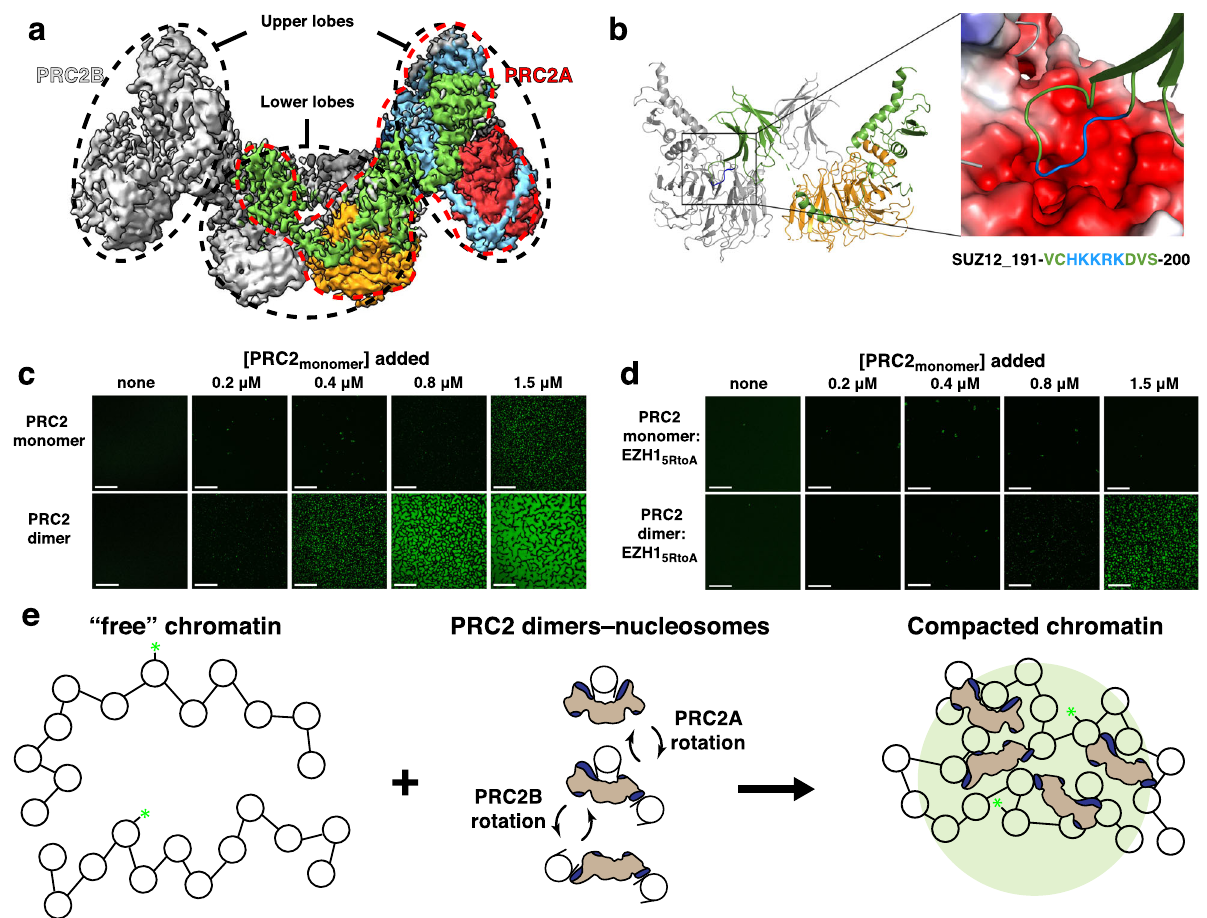
Fig. 3 PRC2 dimers promote chromatin compaction. a Cryo-EM map showing the PRC2:EZH1 dimer. Subunits are colored as in Fig. 1. One PRC2 monomer is highlighted in color and by a red dashed line. b , left panel: Isolated view of the dimeric interface of PRC2:EZH1 showing that the C2 domain of SUZ12 (green) from one PRC2:EZH1 interacts with RBAP48 from the other PRC2:EZH1 (gray). Right panel: Zoomed-in view of the basic loop (blue) in the C2 domain interacting with the acidic surface of RBAP48. Electrostatics were calculated using APBS in PyMol. The sequence of the basic residues in the C2 domain is shown and colored blue. c Confocal micrographs of serial twofold dilutions of PRC2:EZH1 mixed with nucleosome arrays showing compaction of chromatin into droplets. Scale bar: 100 μ m. The fi nal concentration of PRC2 in the reactions is indicated. Molarity is based on the expected size of PRC2: EZH1 monomers. All samples contain 3 μ M total nucleosomes, assembled into arrays with 12 nuclesomes spaced 40 bp apart. Experiments were repeated at least three times with independently puri fi ed complexes and were consistent with each other. d Chromatin compaction as promoted by PRC2:EZH1 5RtoA mutant complexes. Concentrations and scale are as in c . Experiments were repeated twice with independently puri fi ed complexes that were consistent with each other. e Model of chromatin compaction promoted by PRC2 dimers. Chromatin is compacted into a phase-separated state through